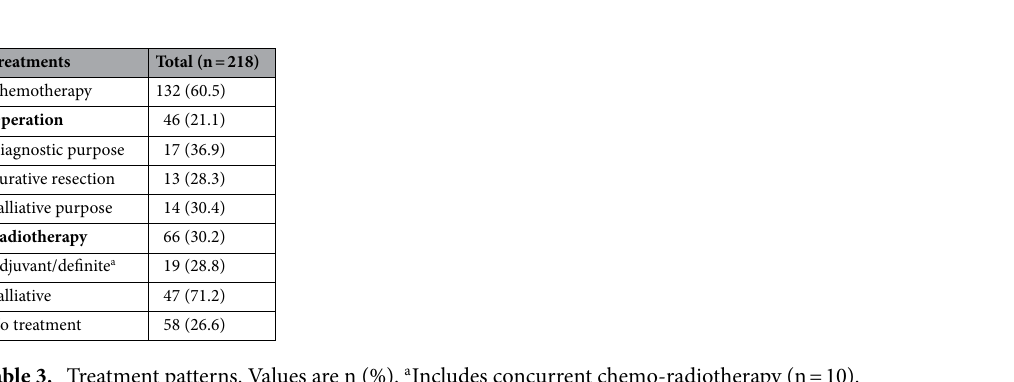
Table 3. Treatment patterns. Values are n (%). a Includes concurrent chemo-radiotherapy (n = 10).